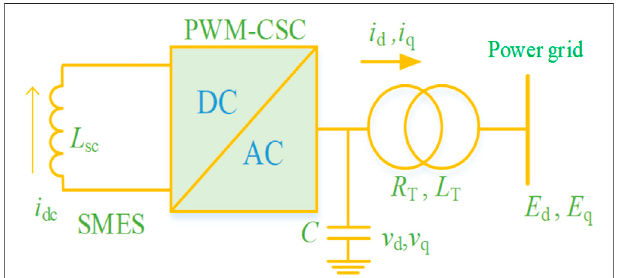
FIGURE 1 | Pulse-width modulated current source converterPWM- CSC)-based superconducting magnetic energy storage (SMES) system connected to an AC power grid.